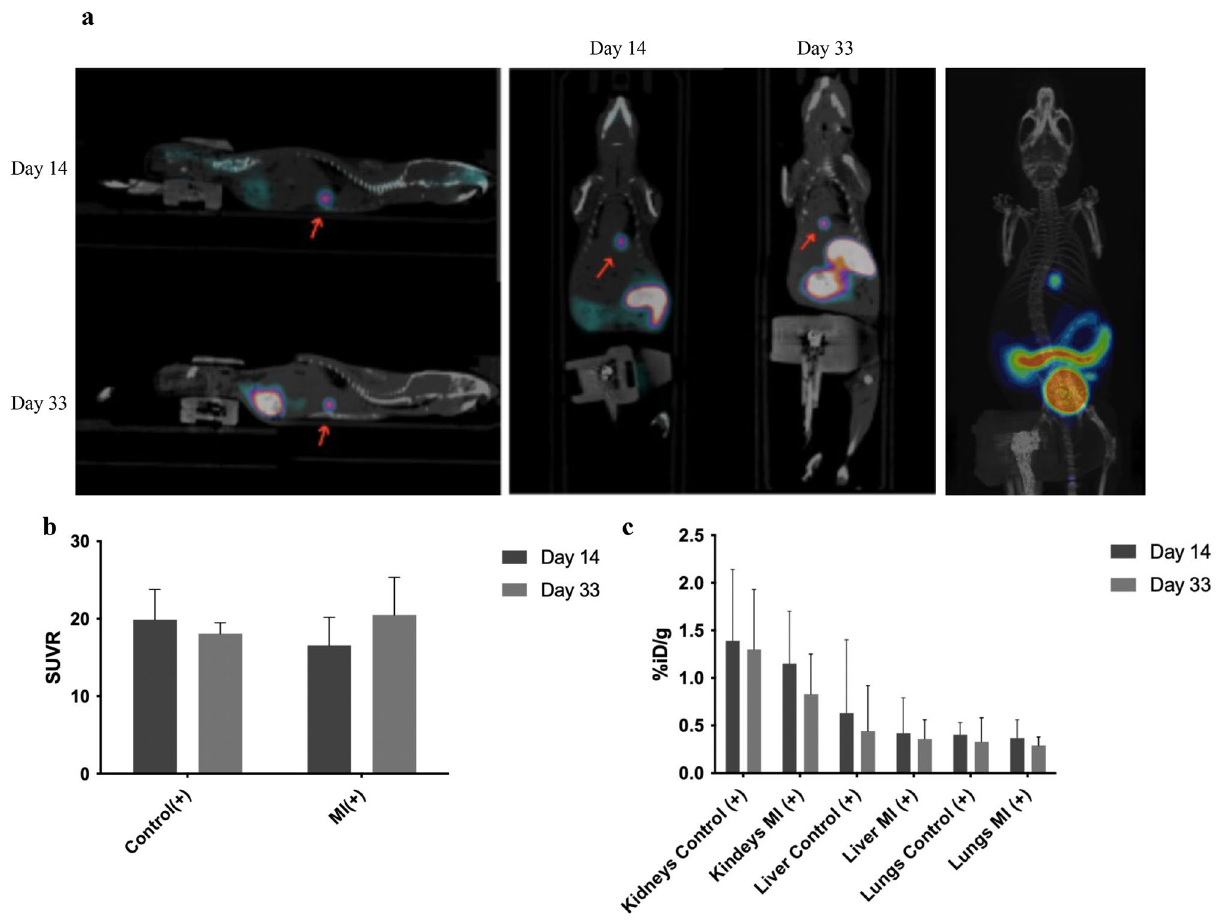
Figure 3. Cellular huSkMDS/PCs EF1-HSV-TK [ 18 F]-FHBG PET Imaging. ( a ) The location of transplanted huSkMDs/PCs EF1-HSV-TK with [ 18 F]-FHBG in the myocardium 14 and 33 days after cell transplantation (on the left) and representative 3D PET/CT image (on the right). ( b ) Comparison of cell retention in the heart over 19 days in control(+) and MI(+) mice. ( c ) Comparison of the biodistribution of the radiotracer. The bladder is detracted from the chart for better